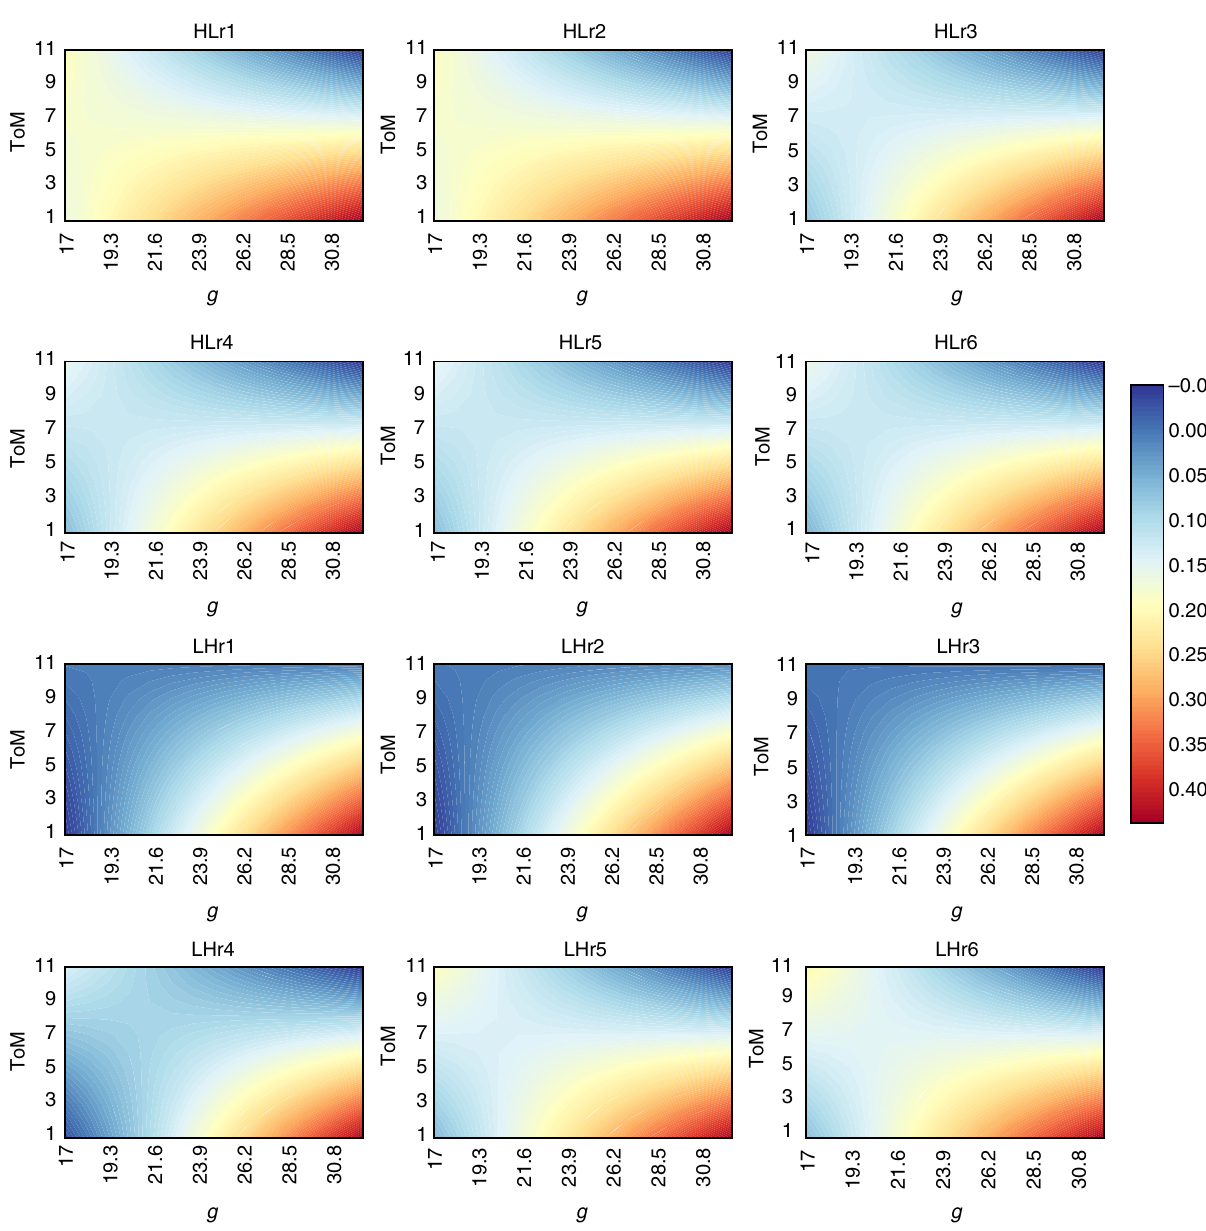
Fig. 3 Marginal effects of g and ToM on Δ T . Blue color less change between the fi rst three and the second three rounds, LH low-to-high resource growth treatment, HL high-to-low resource growth treatment. The different fi gure panels represent the marginal effects of g and ToM for the different